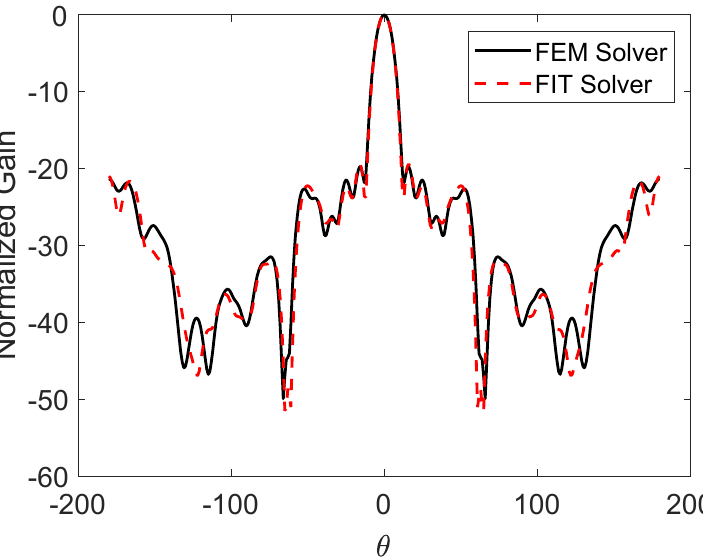
Figure 6. The normalized co ‐ polarized radiation pattern of the horn antenna with a dielectric slabs ‐ based lens using different full ‐ wave simulators. The aperture area of the designed lens is a = 64.52 mm, and the horn antenna is placed at the optimized focal point ( 𝑓 = 50.62 mm).